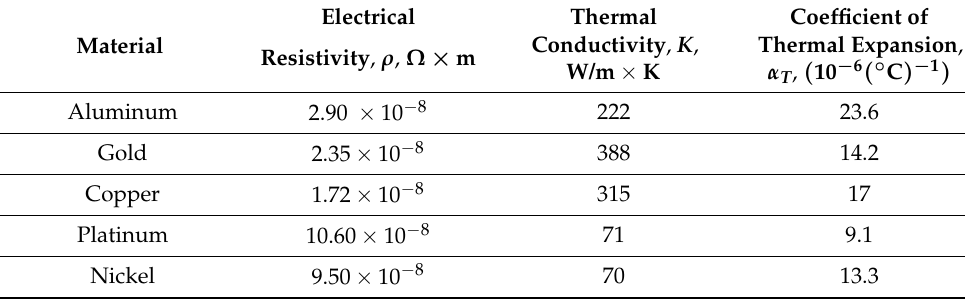
Table 1. Properties of the most common materials for the CPW.